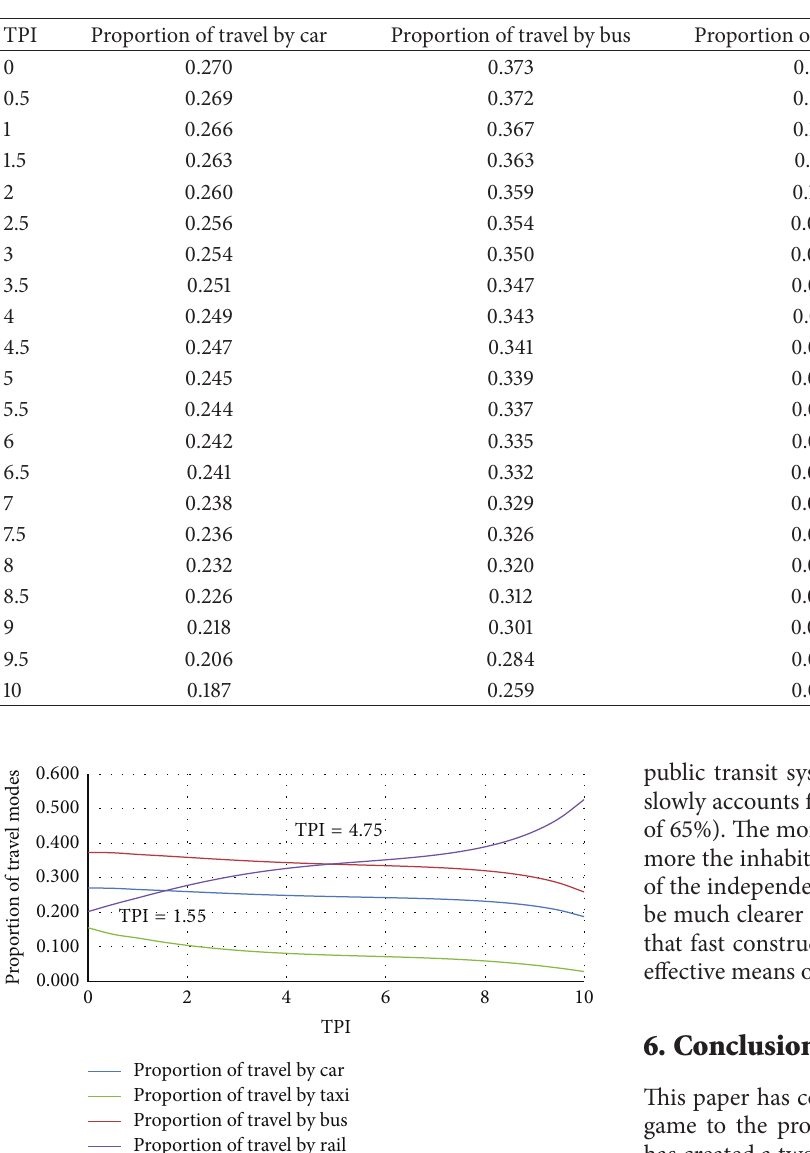
Table 2: Nash equilibrium of travel mode choice game under the TPIs.